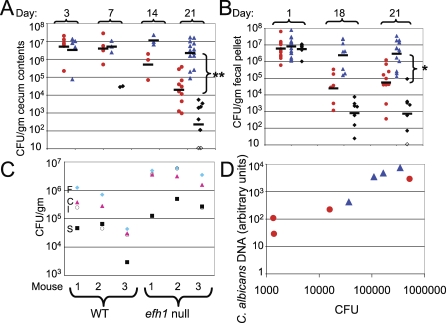
Deletion of EFH1 Alters Murine Intestinal ColonizationWT, efh1 deletion mutant, or EFH1 reconstituted null mutant were orally inoculated by gavage into Swiss Webster mice. At various days post-inoculation, the amounts of C. albicans in fecal pellets and in organs of the intestinal tract were measured.(A) CFUs per gram of cecum contents from mice sacrificed on the indicated days post-inoculation. Each symbol represents a sample from a different mouse. (Composite results from several experiments.) Red circles, WT C. albicans strain DAY185 (23 mice); blue triangles, efh1 deletion mutant strain CKY366 (24 mice); black diamonds, EFH1 reconstituted strain, CKY373 (ten mice); open symbols, no colonies detected; bars, geometric means. p-Value was determined using the t test with log transformed data. ** indicates p < 0.000005.(B) CFUs per gram of fecal pellet. Mice were sampled repeatedly and each symbol represents a sample from a different mouse. Different numbers of mice are shown on different days because some mice were sacrificed earlier and some mice were sampled on different days. Red circles, WT C. albicans strain DAY185 (ten mice); blue triangles, efh1 deletion mutant strain CKY366 (12 mice); black diamonds, EFH1 reconstituted strain, CKY373 (seven mice); open symbols, no colonies detected; bars, geometric means. p-Value was determined using the t test with log transformed data. * indicates p < 0.0003.(C) Correlation between CFUs measured in several organs and in fecal pellets. Light blue diamonds, fecal pellets (labeled F); pink triangles, cecum contents (labeled C); open circles, ileum contents (labeled I); squares, stomach contents (labeled S). CFU/gm of cecum contents, stomach contents, and fecal pellets correlated well, while the CFU/gm ileum was more variable.(D) Mice were colonized with WT strain DAY185 (red circles) or efh1 null mutant CKY366 (blue triangles) or were not inoculated with C. albicans (not shown). Mice were sacrificed on day 21 post-inoculation, CFUs from cecum contents were determined by plating, and C. albicans DNA in cecum contents was quantified by qPCR as described in Materials and Methods. The correlation between CFUs in 70 mg of pelleted cecum contents (x-axis) and DNA (in arbitrary units) determined by qPCR (y-axis) is shown. Each symbol represents a different mouse.